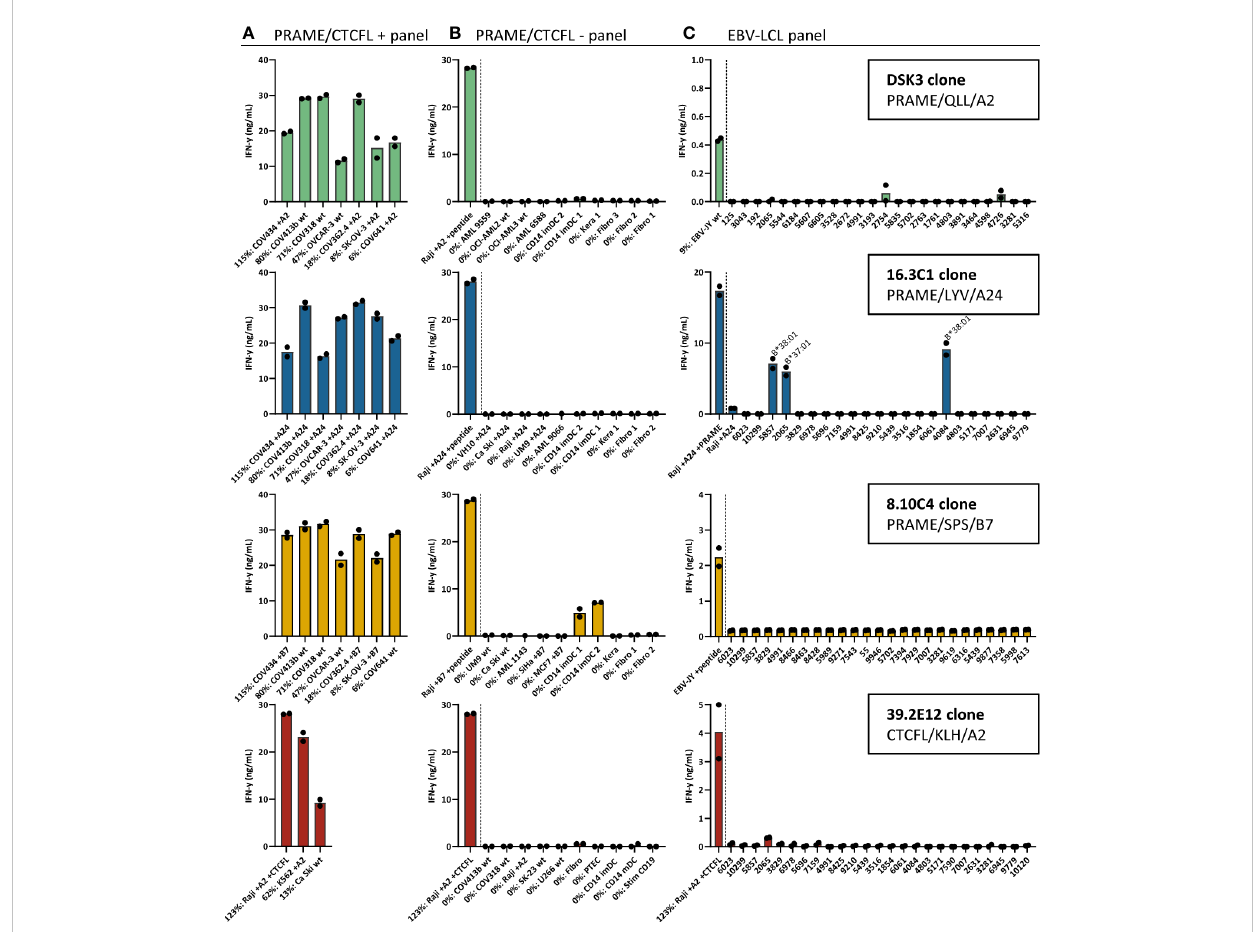
FIGURE 3 Recognition patterns of the selected T-cell clones recognizing PRAME or CTCFL positive tumor cells, without substantial peptide or HLA cross-reactivity. Recognition patterns based on IFN- g production (ng/mL) after overnight coculture assays with (A) PRAME or CTCFL positive tumor cell lines, (B) PRAME or CTCFL-negative tumor cell lines and healthy cell subsets, and (C) 25 EBV-LCLs, expressing all HLA alleles with an allele frequency ≥ 1% present in the Caucasian population. The HLA allele in (C) is depicted if an HLA allele is recognized by the T-cell clone, meeting the requirement that all EBV-LCLs with this HLA allele are recognized. All cell lines in (A, B) express the HLA allele that presents the targeted peptide, either wildtype or the HLA allele was introduced by transduction (+A2, +A24 or +B7). Percentage relative PRAME or CTCFL expression is depicted, as determined by qPCR. Bars represent mean and symbols depict technical duplicates. (EBV-LCL: Epstein-Barr virus transformed lymphoblastoid cell